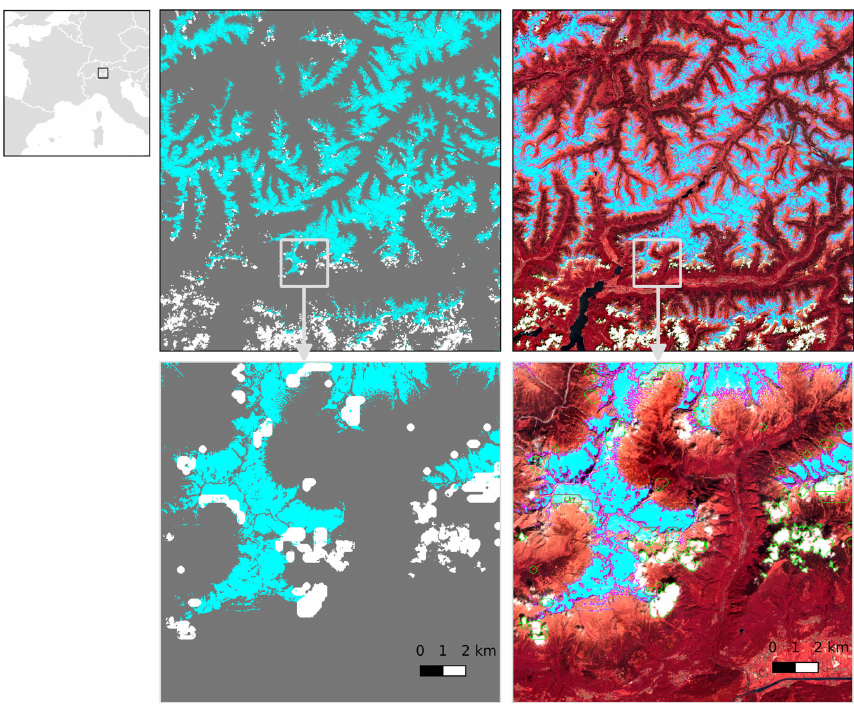
Figure 7. Example of a snow map ( SNW file) and its corresponding colour composite ( CMP file). In the snow map the snow is represented in cyan, no snow in grey and cloud in white. In the RGB composite, the snow-covered areas are delineated in magenta, while the clouds are delineated in green (Theia snow product of tile 32TNS on 27 May